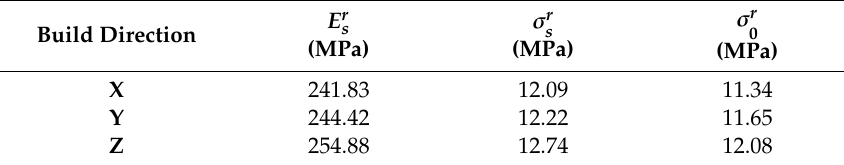
Table 2. Equivalent elastic moduli and stresses for t = 0 and t → ∞ .